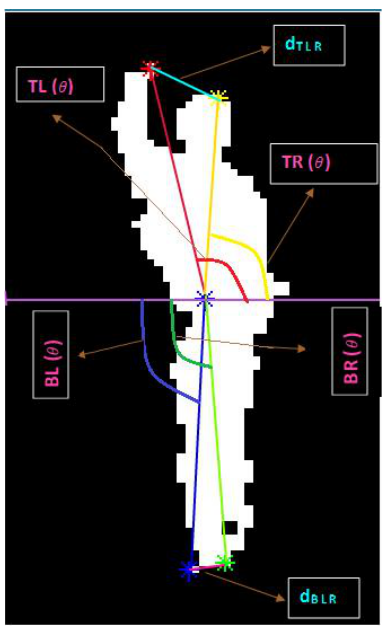
8 Figure 3. Geometric feature extraction from human blob.